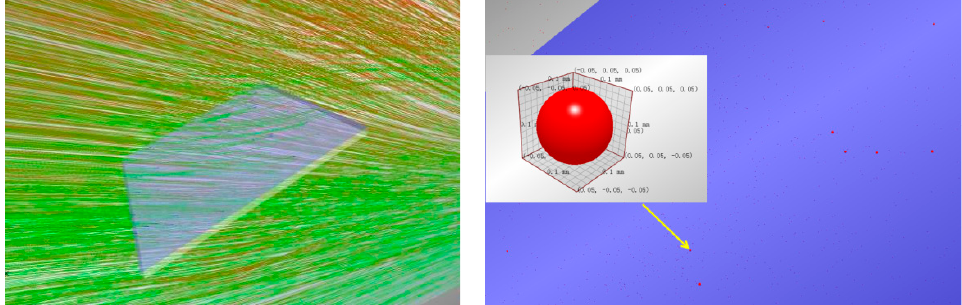
Figure 9. Movement of dust particles around solar panel. ( left ) Particle streamlines; ( right ) dust particles settled on the solar panel, where the red point indicates dust particles.